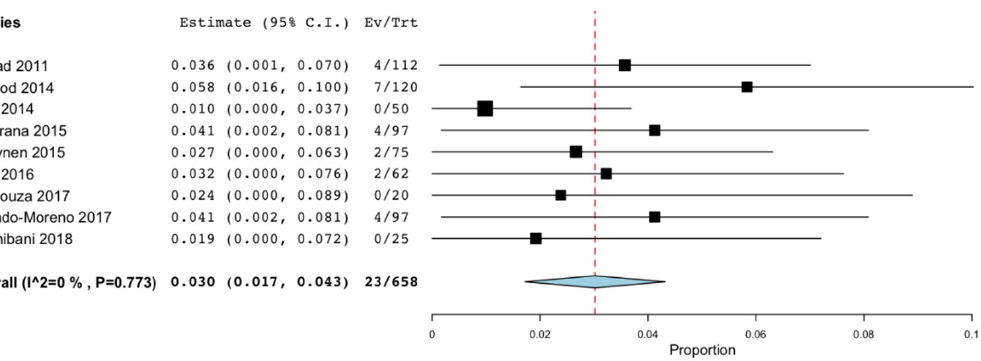
Figure 5. Failure rate at 36 months.